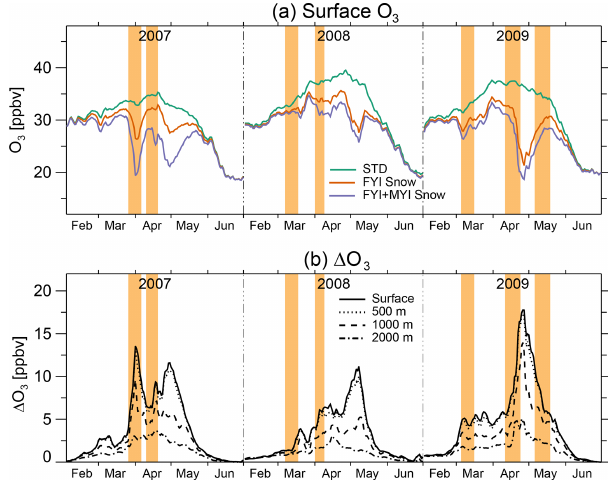
Figure 10. Time series of daily mean surface O 3 and decrease in surface O 3 ( (cid:49) O 3 ) due to blowing snow at high latitudes ( > 60 ◦ N) between February and June 2007–2009. (a) Daily mean surface O 3 mixing ratios averaged poleward of 60 ◦ N for the STD (blue line), FYI Snow (purple), and FYI+MYI Snow (red line) GEOS- Chem simulations. (b) Daily mean (cid:49) O 3 , obtained as the difference between the FYI+MYI Snow and STD simulations at the surface (solid line), 500m altitude (dotted line), 1000m altitude (dashed line), and 2000m altitude (dash-dotted line). The events highlighted in light orange are defined as periods when GOME-2 or OMI BrO hotspots cover more than 2 × 10 6 km 2 for longer than